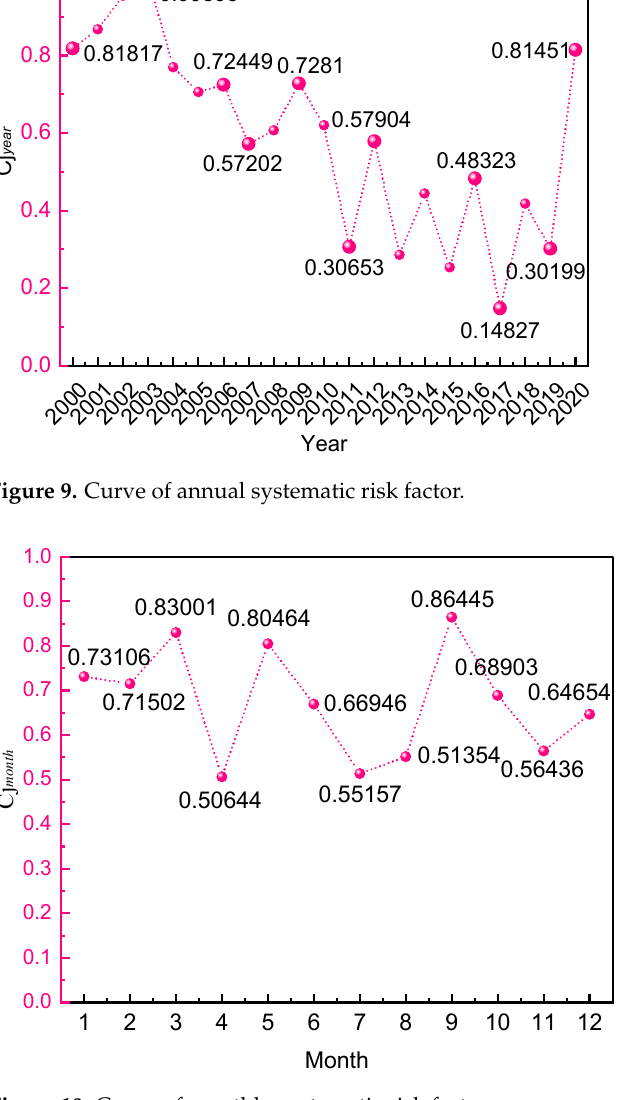
Figure 10. Curve of monthly systematic risk factor.